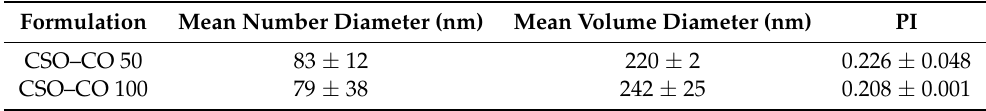
Table 1. Dimensions and polydispersion index (PI) of NEs (mean ± sd; n = 3).